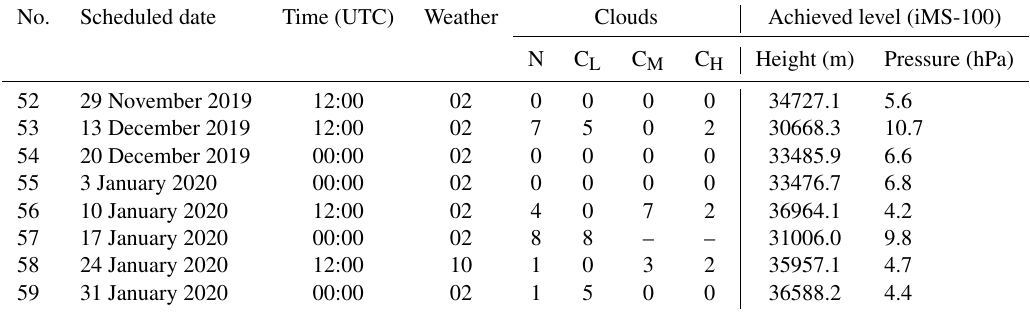
Table 7. Pressure range for allocation of iMS-100–RS92 differences based on RS92 pressure (i.e. bottom ≥ P RS92 Layer